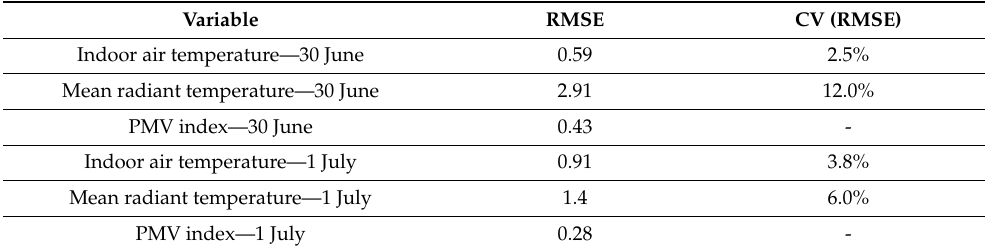
Table 4. Summary table of statistical analysis of differences between measurement and